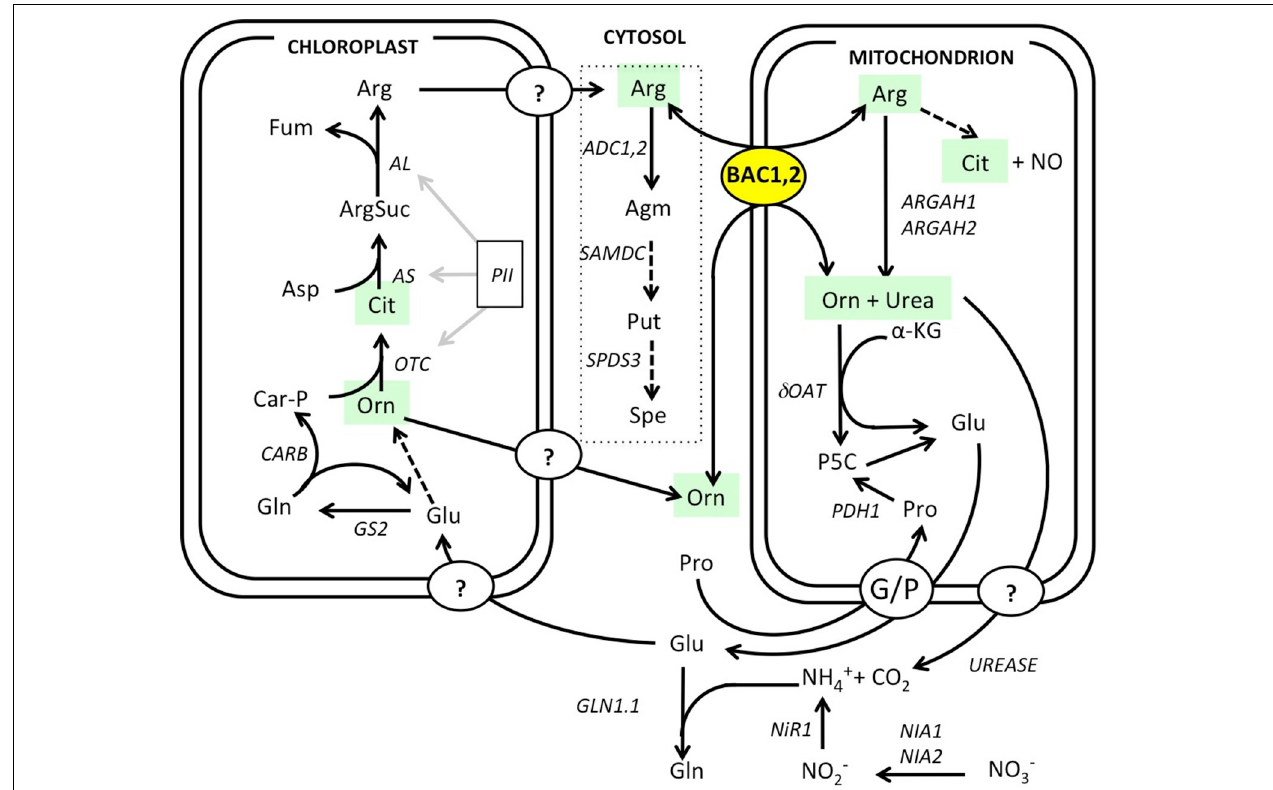
FIGURE 1 | Overview of arginine mitochondrial transport and metabolism. Arginine metabolism map drawn according to Slocum (2005), Funck et al. (2008), and Witte (2011). Polyamine biosynthesis pathway is outlined (dotted line). Dotted arrows represent pathways with additional steps that are not detailed here. Enzyme and protein abbreviations and references: ADC, arginine decarboxylase (ADC1 At2g16500, ADC2 At4g3471); AL, argininosuccinate lyase (At5g10920); AS, argininosuccinate synthase (At4g24830); ARGAH, arginase (ARGAH1 At4g08900, ARGAH2, At4g08870); BAC, basic amino acid carriers BAC1 (At2g33820) and BAC2 (At1g79900); GS, glutamine synthetase (GS2, At5g35630); GLN, glutamine synthetase (GLN1.1 At5g37600); NIA, nitrate